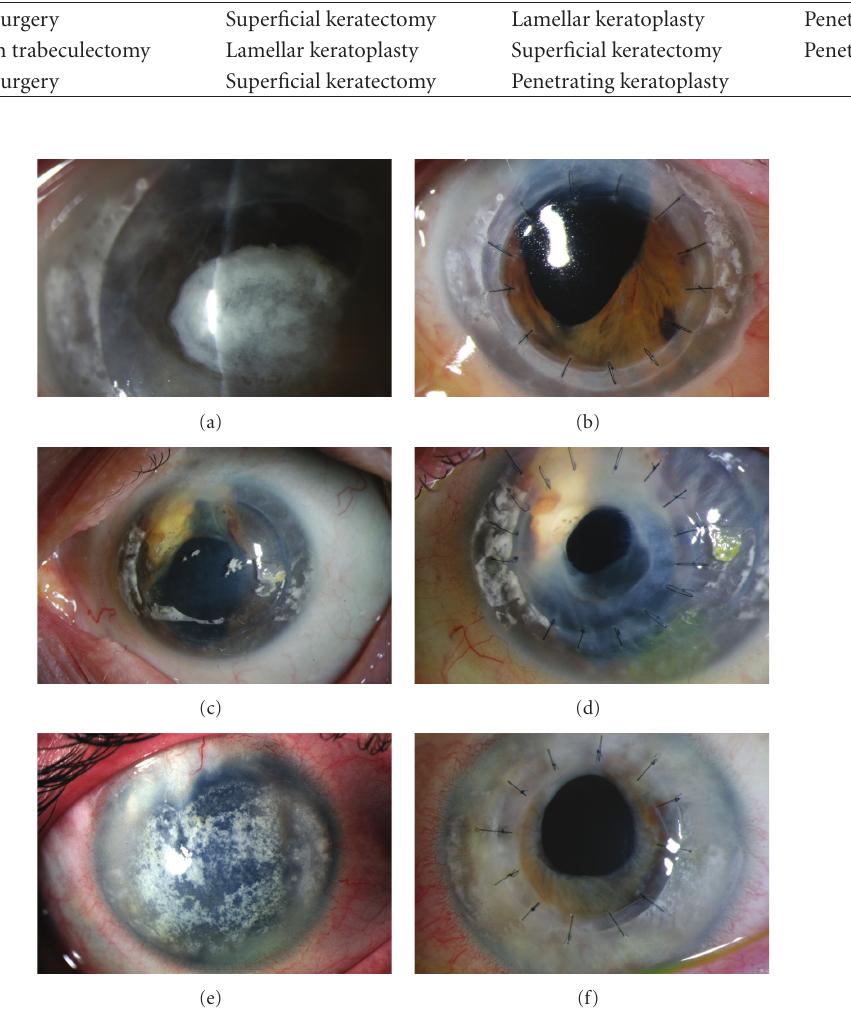
Figure 1: (a) Slit lamp biomicroscopy showing corneal decompensation and band keratopathy in patient 1. (b) Postoperative picture showing clear corneal graft of the same patient. (c) Preoperative slit lamp biomicroscopy showing corneal degeneration in patient 2. (d) Slit lamp biomicroscopy showing clear graft of patient 2. (e) Preoperative slit lamp biomicroscopy showing corneal changes in the form of degeneration in patient 3. (f) Postoperative clear corneal graft in patient